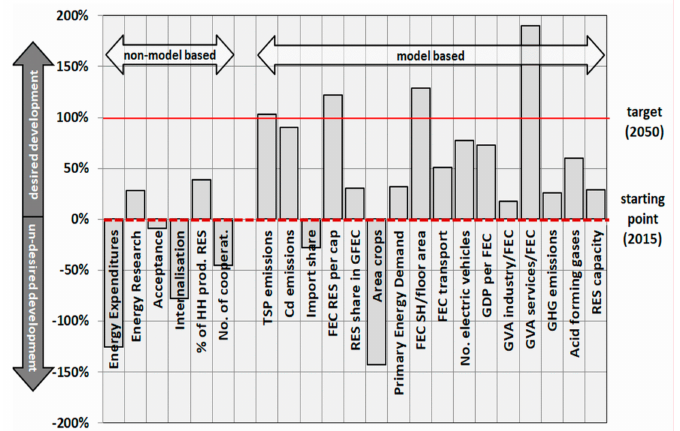
Figure 2. Summary of assessment results for the 22 indicators in the scenario